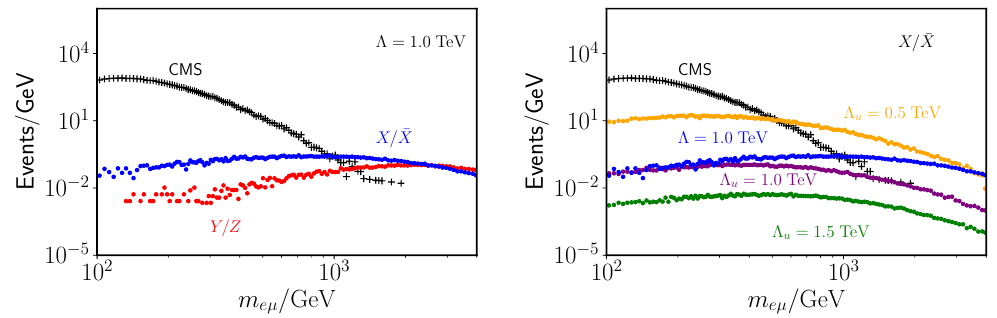
Figure 2 . The invariant mass distribution of selected e(cid:22) pairs for the signals together with CMS data shown in black. With (cid:3) = 1 TeV and no unitarisation, signals in the left panel are in blue for ( 0 ) ( 0 ) , (cid:22) and in red for . In the right panel, signals for operator X X O O O Y;Z unitarisation and (cid:3) u = 0 : 5, 1 and 1 : 5 TeV with unitarisation are shown in orange, purple and green